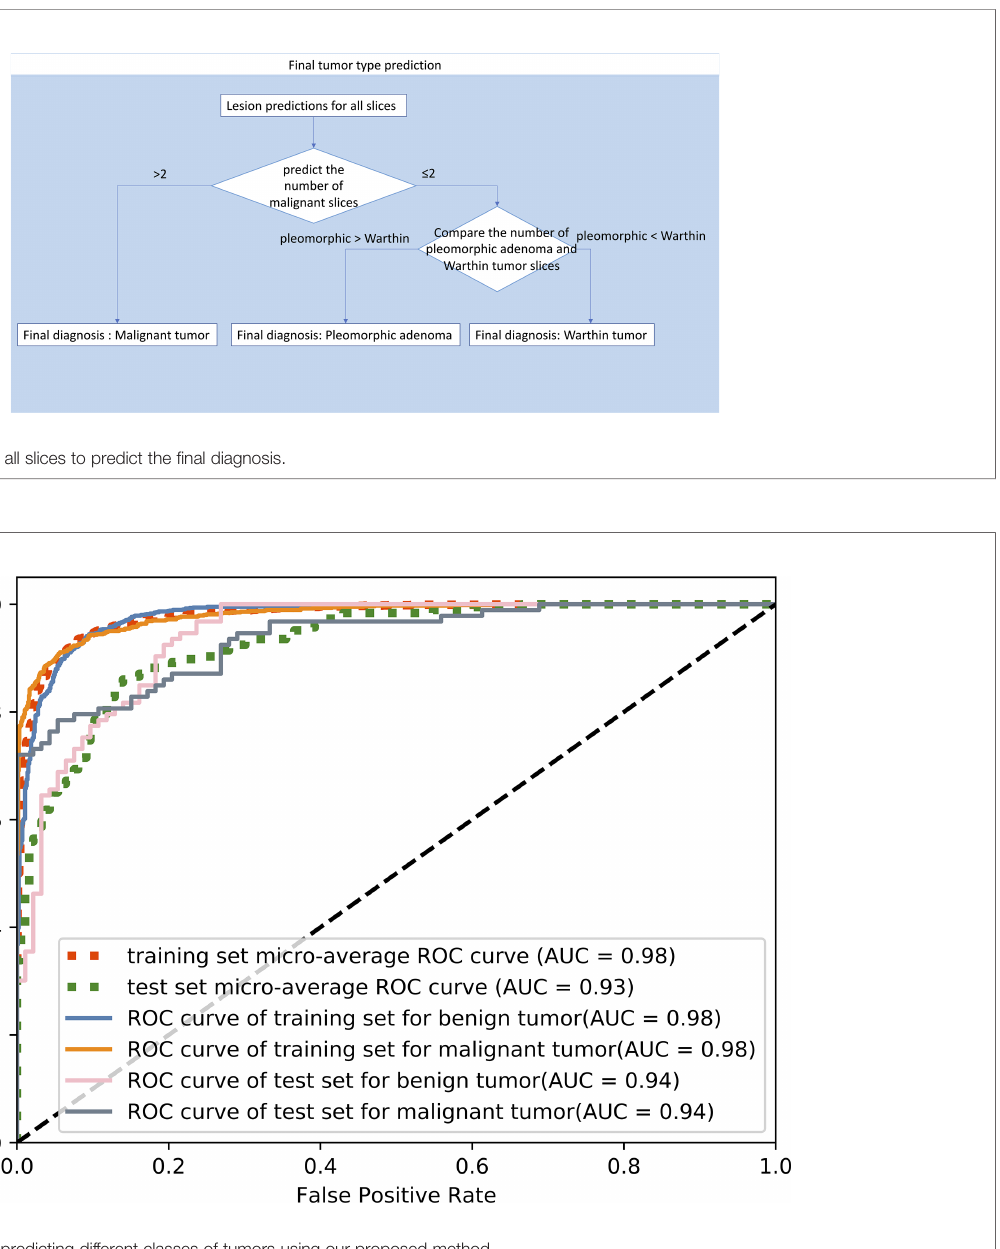
FIGURE 6 | The ROC curves for predicting different classes of tumors using our proposed